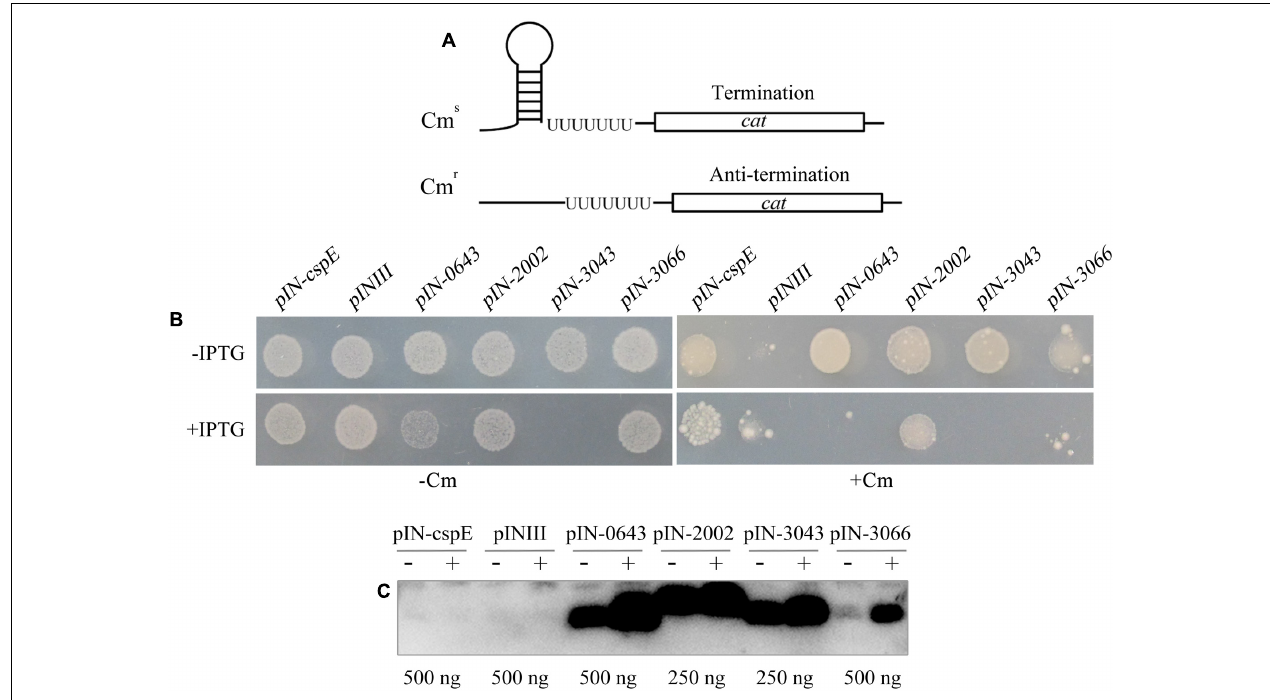
FIGURE 3 | Determination of transcriptional antitermination of TRAM proteins. (A) E. coli RL211 carrying a cat gene cassette positioned downstream of the trpL terminator serves as the reporter. Termination (upper figure) and melting of the structured RNA terminator (below figure) allows expression of the chloramphenicol resistance gene cat . (B) Cells were transformed with pINIII vector alone or pINIII carrying cspE, Mpsy _0643 , Mpsy_2002 , Mpsy_3043 , and Mpsy _ 3066 , as indicated. Cultures were adjusted to an optical density at 600 nm of 1.0 by dilution with fresh medium and 10-fold serially diluted and spotted onto LB plates containing 100 µ g/ml ampicillin with or without 0.2 mM IPTG ( ± IPTG) and 30 µ g/ml chloramphenicol ( ± Cm) as indicated (Supplementary Figure S4B). Growths with Cm (10 0 ) and without Cm (10 - 3 ) were shown. (C) Using the antibody against TRAM2002, Western blot was performed to determine the abundance of the four TRAM proteins in E. coli RL211. The empty plasmid pINIII and bacterial CspE were included as negative controls. The amount of loaded total protein for each TRAM gene cloned strain is shown beneath the gel. ± on the top of each lane indicates the presence or absence of